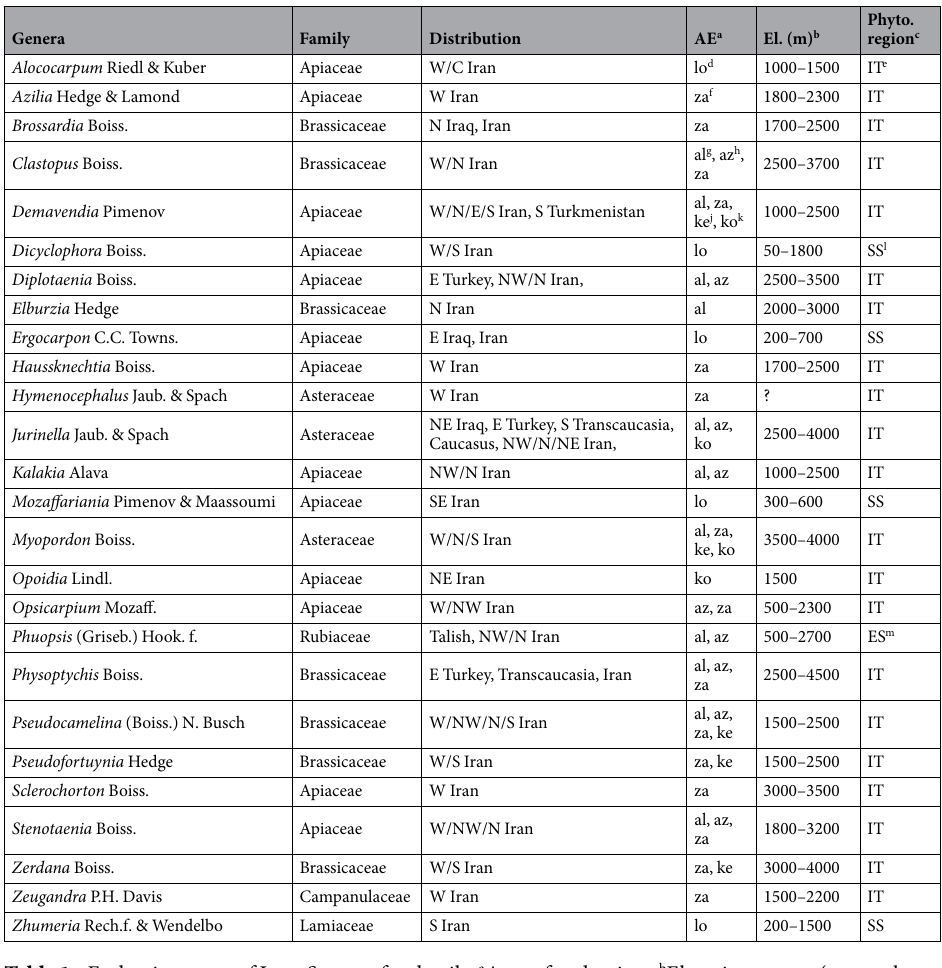
Table 1. Endemic genera of Iran. See text for details. a Area of endemism; b Elevation ranges (meter above sea level); c Phytogeographical regions; d Lowland; e Irano-Turanian; f Zagros; g Alborz; h Azerbaijan Plateau; j Yazd-